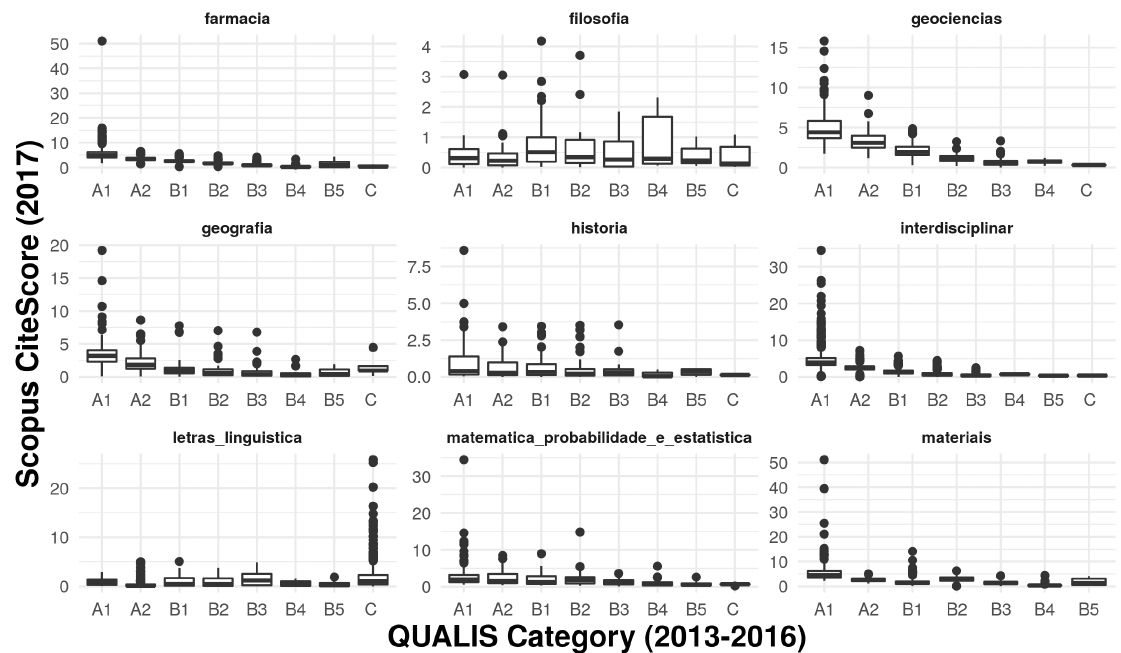
Figure 6. Scopus CiteScore variation across QUALIS categories in nine subject area. Original QUALIS subject area names are shown (as written in their respective classification sheets) but their English translation can be found in Table